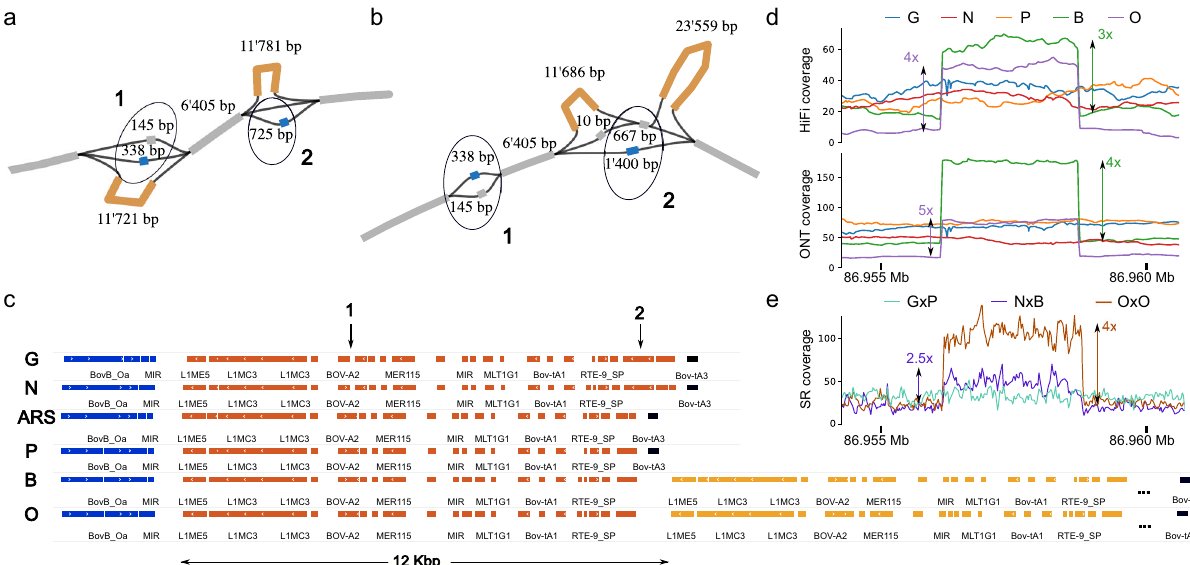
Fig. 6 Topology of a tandem duplication on BTA6. a , b Example subgraphs of the promoter region of GC from ( a ) hi fi asm- and ( b ) Shasta-based pangenomes respectively. Reference paths (including those in bubbles) are colored gray, while the tandem duplications are orange. Two insertions observed uniquely in Nellore and gaur haplotypes are blue, shown in circles 1 and 2. Complex bubbles generally have suboptimal topologies due to the lack of base-level alignment. For example, the 725 bp insertion is obvious in a), but appears as the difference between a 1400 bp and 667 bp path in ( b ). However, both subgraphs identify the approximately 200 bp (1) and 700 bp (2) insertions in Nellore and gaur, as well as the tandem duplication in Brown Swiss and Original Braunvieh. c The 12 Kb repeat structure (orange) is clearly identi fi ed by RepeatMasker across all assemblies, shown here for the ARS- UCD1.2 reference and Shasta assemblies for gaur, Nellore, Piedmontese, Brown Swiss, and Original Braunvieh. The two marked gaur/Nellore insertions (1&2) are consistent with the pangenomes in ( a , b ). One additional copy in Brown Swiss and Original Braunvieh is shown (yellow), while the tandem duplication eventually ends with a similar repeat (Bov-tA3, black) to the other assemblies. d The identi fi ed CNV region shows clear coverage increase in only Brown Swiss and Original Braunvieh, across both HiFi and ONT haplotype-resolved reads, although the HiFi reads suggest one less additional copy than ONT reads. e F1 short reads also show increased coverage for the NxB and OxO trios. The NxB coverage increase is consistent with only the Brown Swiss haplotype carrying additional